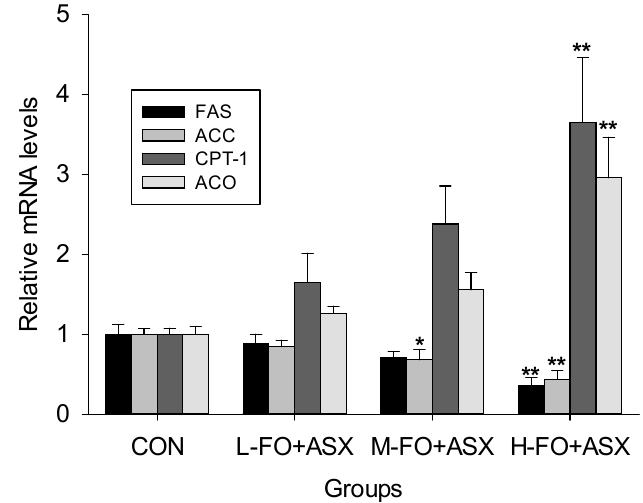
Figure 5. Effects of FO and ASX on hepatic FAS, ACC, CPT ‐ 1 and ACO mRNA. CON: high ‐ fat diet group; L ‐ . M ‐ and H ‐ FO + ASX: low, moderate, and high FO and ASX groups. Bars represent means ± SEM from 4 independent experiments. * p < 0.05 and ** p < 0.01 compared to CON group.